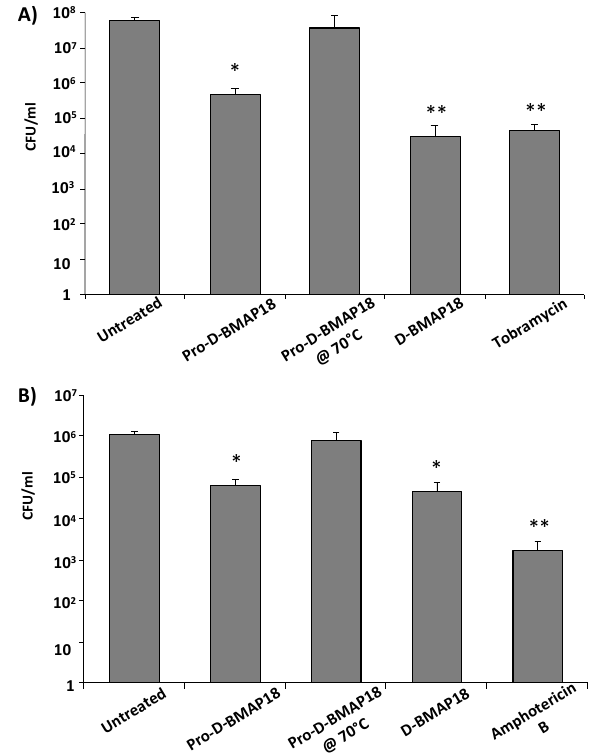
Figure 3. Antimicrobial activity of Pro-D-BMAP18 in 25% ( v / v ) CF sputum in SCFM + 300 mM NaCl. CFU/mL count of ( A ) P. aeruginosa RP73 and ( B ) C. albicans SC5314 after 4 h incubation with Pro-D-BMAP18 (64 μ g/mL), D-BMAP18 (64 μ g/mL), tobramycin (8 μ g/mL), and amphotericin B (1 μ g/mL). Pro-D-BMAP18 (64 μ g/mL) in heat-inactivated sputum was used as a negative control for enzymatic activity. Results are from three separate experiments in internal duplicate (n = 6). * = p < 0.05; ** = p < 0.01. A Student’s t -test of the treatments vs the untreated control is indicated.